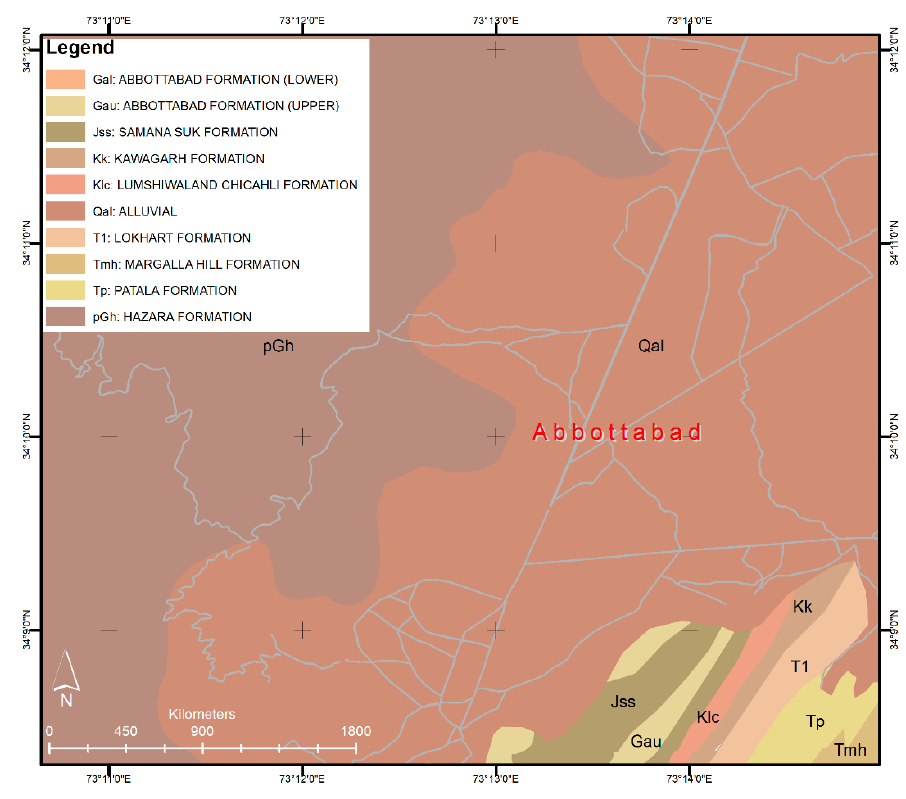
Figure 4. Geological map of the study area.